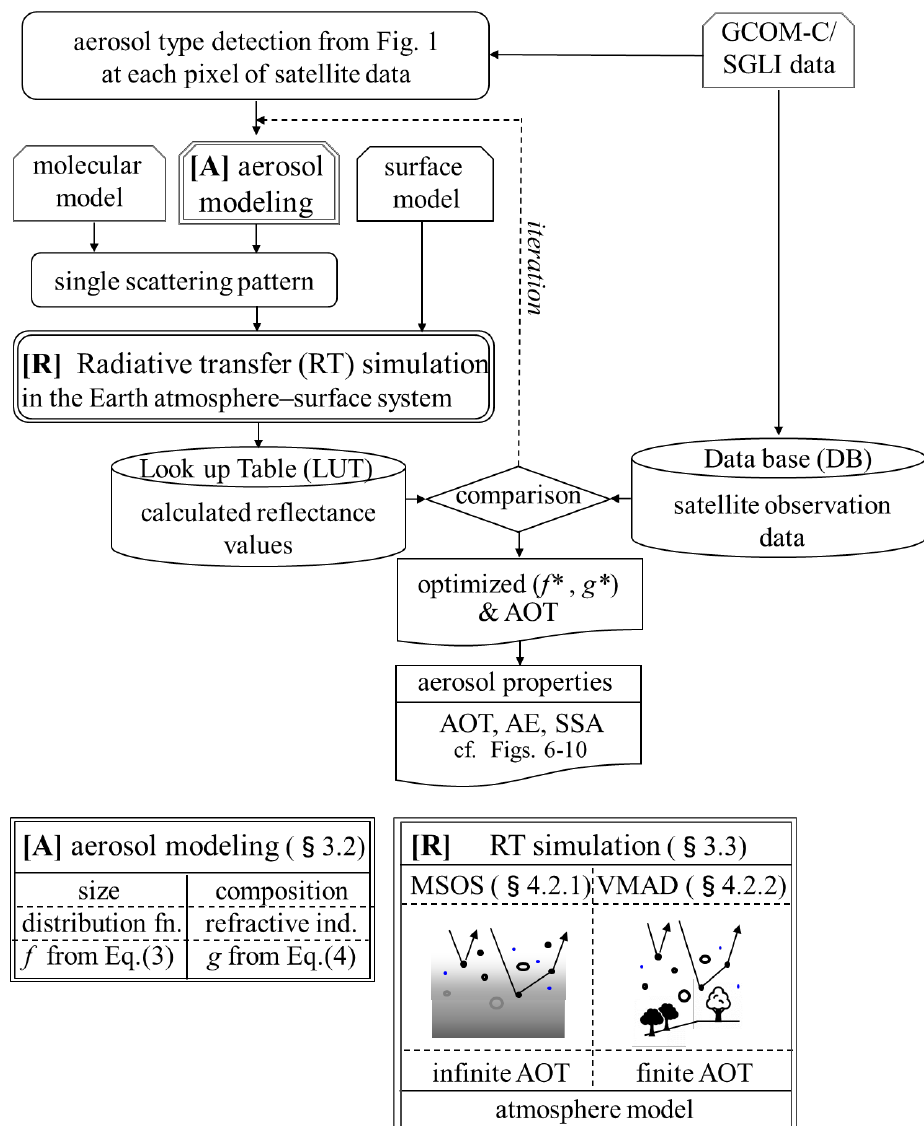
Figure 3. Basic framework and block flow of our aerosol retrieval method. The aerosol properties AOT, AE and SSA denote aerosol optical thickness, Ångström exponent and single scattering albedo, respectively. MSOS and VMAD of RT method represent method of successive order of scattering and vector method of adding-doubling, respectively.